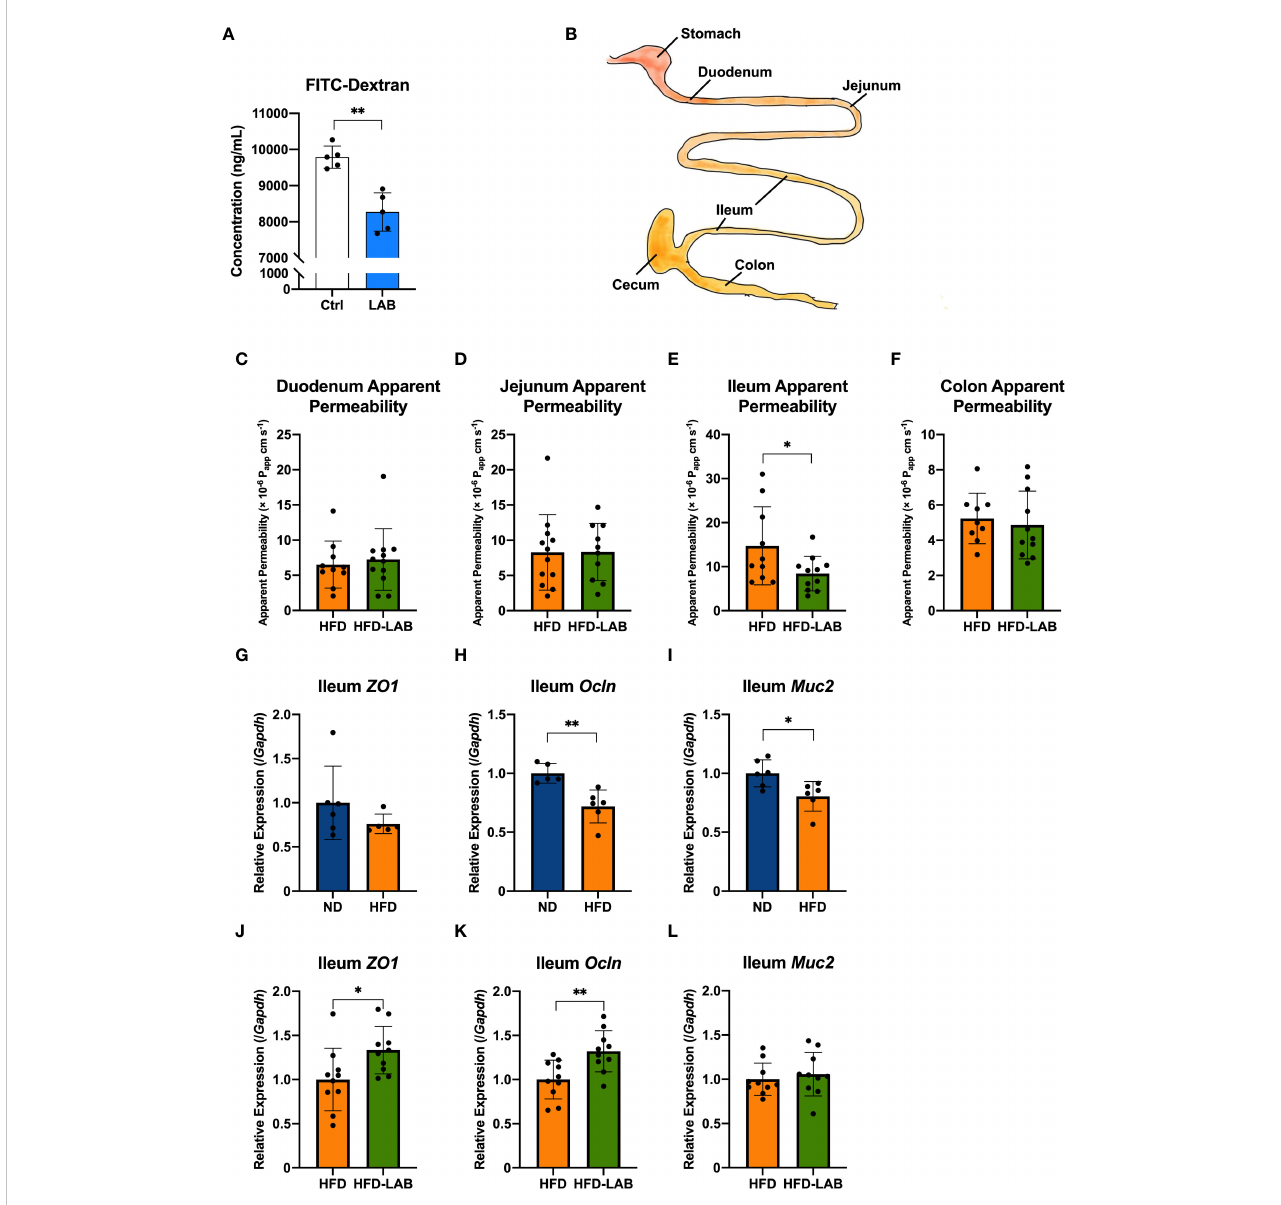
FIGURE 2 L. plantarum OLL2712 exhibited the ability to decrease intestinal permeability, especially in the distal intestine. (A) C57BL/6N male mice were treated with OLL2712 (4 mg dissolved in 200 m L water for each dose) for 7 days, and mice treated with water simultaneously were used as a control group (Ctrl) (n = 5). The concentration of FITC-dextran in serum was measured and calculated 4 hours after FITC-dextran was orally administered to mice to investigate epithelial permeability in vivo . (B) Speci fi c intestinal sections were collected, and the permeability of each section was assessed. A 4 cm segment under the stomach was selected as the duodenum, a segment from the 5th to the 10th centimetre below the stomach as the jejunum, a 5 cm intestinal section proximal to the cecum as the ileum, and a 5 cm segment below the cecum as the colon. The apparent permeability of the duodenum (C) , jejunum (D) , ileum (E) , and colon (F) in C57BL/6N male mice fed an HFD and treated with OLL2712 (HFD-LAB) were compared with those fed an HFD and treated with sterilized water (HFD) (n = 9 - 12). The relative expression of ZO-1 ( ZO1 ) (G) , Occludin ( Ocln ) (H) , and MUC2 (I) in ileal tissues from ND or HFD-fed mice was measured by qPCR (n = 5 - 6). The relative expression of ZO-1 ( ZO1 ) (J) , Occludin ( Ocln ) (K) , and MUC2 (L) in ileal tissues from mice fed HFD and treated with OLL2712 (HFD-LAB) were compared with those fed HFD and treated with sterilized water (HFD) (n = 10). The results are representative of two independent experiments and are shown as the mean ± standard deviation. * p <0.05; ** p <0.01 (assessed using Student ’ s t -test). Ctrl, control; LAB, lactic acid bacteria ( L. plantarum OLL2712); ND, normal diet; HFD, high-fat